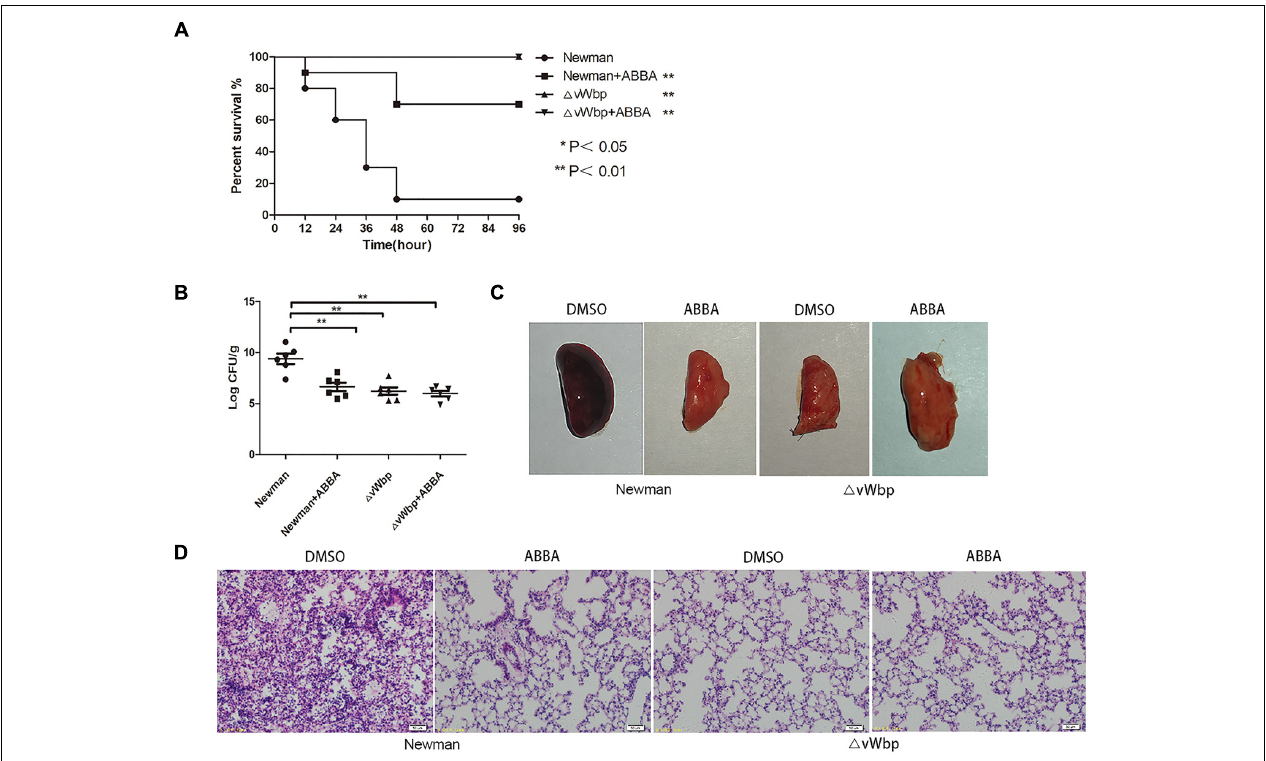
FIGURE 7 | ABBA protects mice against S. aureus pneumonia. Mice were infected via intranasal administration with S. aureus Newman or S. aureus Newman (cid:49) vWbp. (A) Survival was monitored at 12, 24, 36, 48, 60, 72, 84, and 96 h. ( n = 10) The asterisks indicate statistical significance versus the Newman-infected group using the log-rank test. (B) CFU counts in the lungs of infected mice 24 h post-infection. Gross pathological changes (C) and histopathology (D) of lung tissue infected with S. aureus , which was treated with either DMSO or ABBA. ( n = 6) ∗∗ indicates P < 0.01 compared with the Newman group and Newman (cid:49) vWbp group.